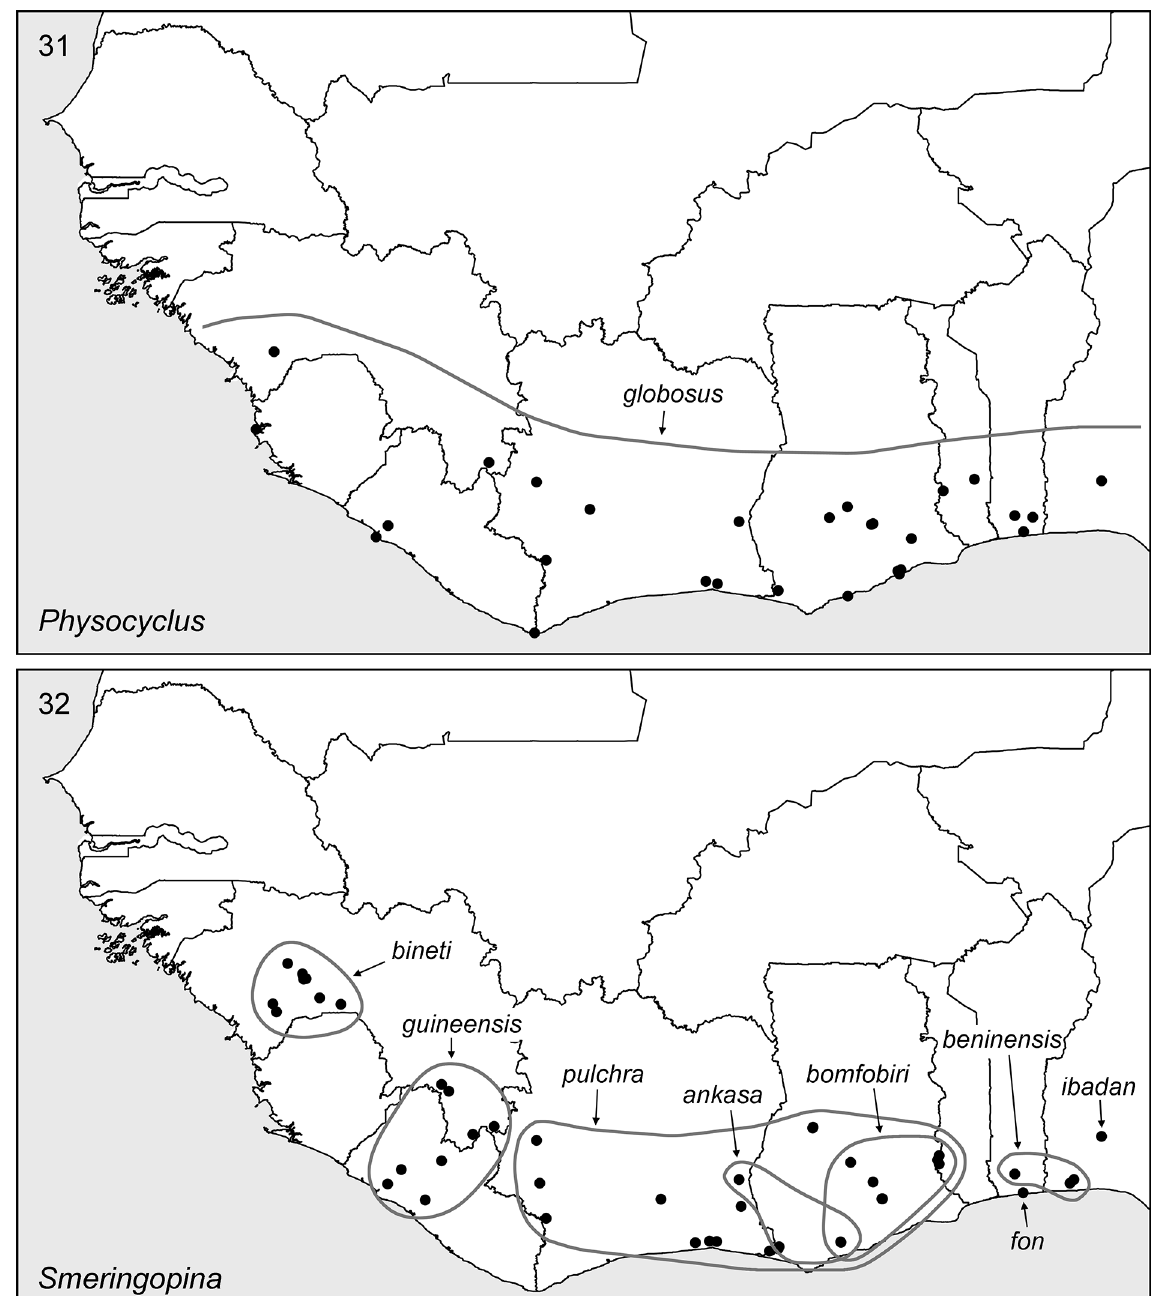
Figs 31-32. Known distributions of the genera Physocyclus Simon, 1893 and Smeringopina Kraus, 1957 in West